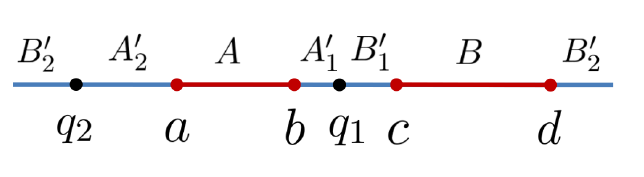
Figure 4: Double interval